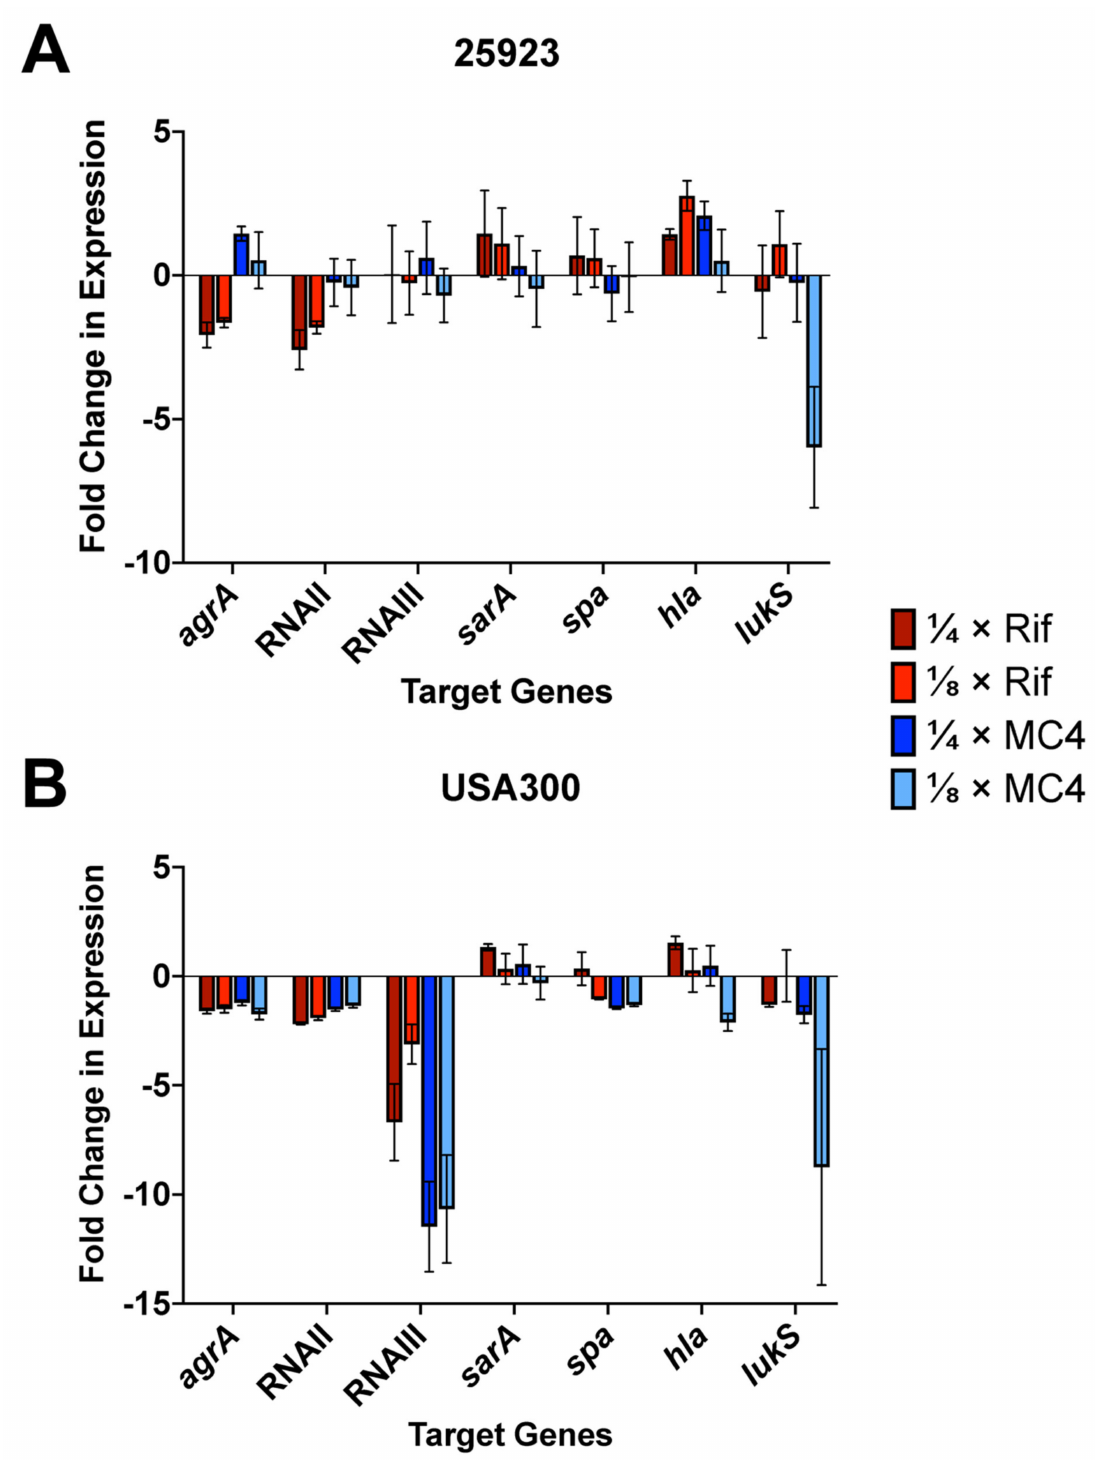
Figure 7. Effects of subinhibitory levels of MC4 and rifampicin on the relative expression of virulence-associated genes in ( A ) S. aureus ATCC ® 25923 and ( B ) MRSA strain USA300. Probed transcripts belong to the staphylococcal SarA / SarR ( sarA ) and agr regulons ( agrA , RNAII, RNAIII), as well as clinically significant exotoxins Protein A ( spa ), α -toxin ( hla ) and PVL ( lukS ). Fold change values (2 − ∆∆ CT for upregulation; 1 / − 2 − ∆∆ CT for downregulation) were extrapolated from ∆∆ C T calculations. Experiments were performed in triplicates. 25923: S. aureus ATCC ® 25923; USA300: CA-MRSA strain USA300; Rif: